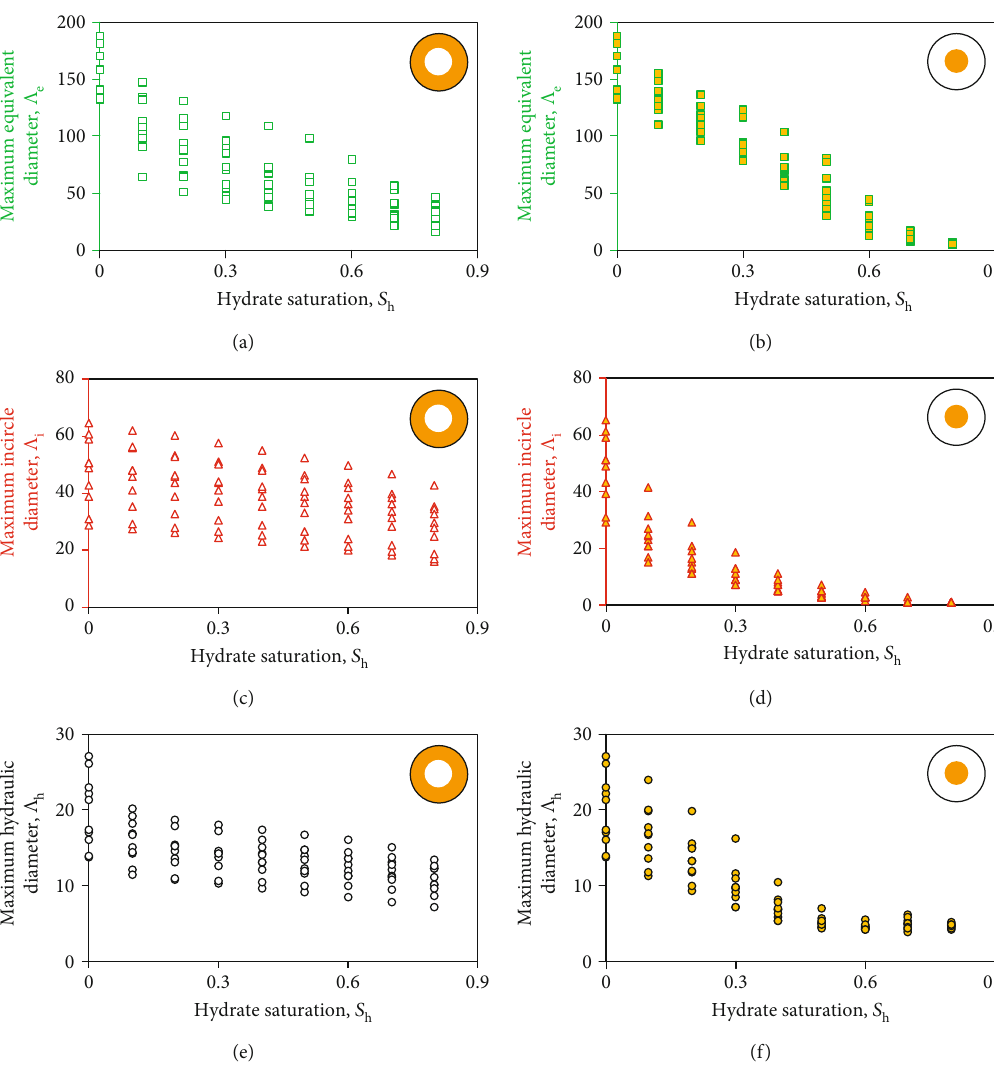
Λ Λ fl uid-occupied pores within hydrate-bearing porous media Figure 3: The maximum equivalent Λ e , incircle i , and hydraulic h diameters of evolving with hydrate saturation S h . The maximum equivalent diameter Λ e for grain-coating (a) and pore- fi lling (b) hydrates. The maximum incircle diameter Λ i for grain-coating (c) and pore- fi lling (d) hydrates. The maximum hydraulic diameter Λ h for grain-coating (e) and pore- fi lling (f)